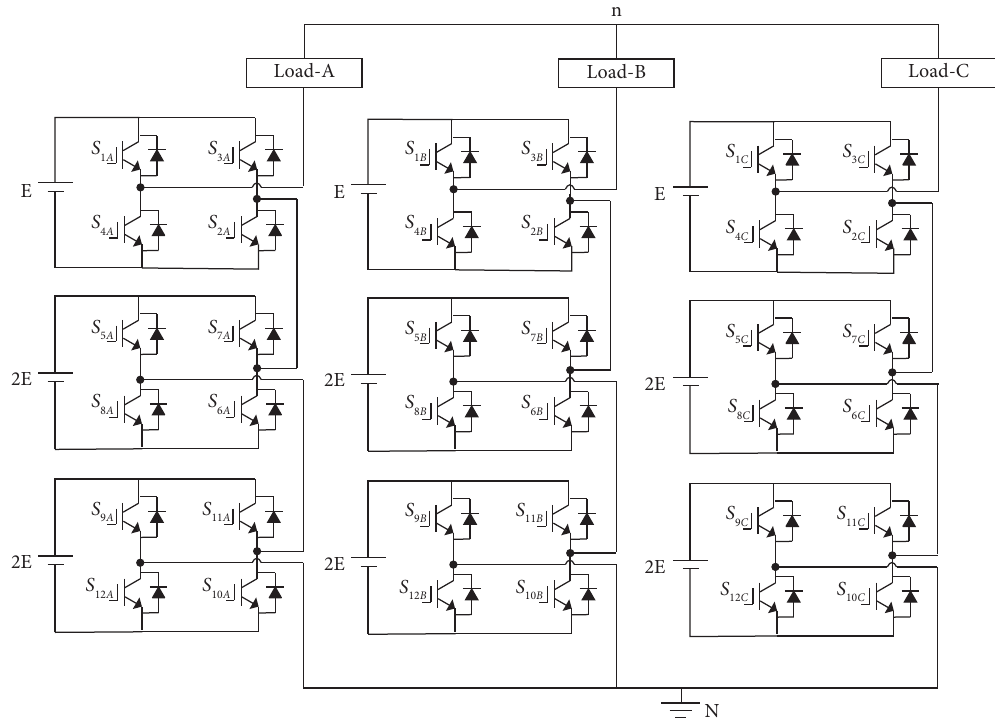
Figure 1: Tree phase asymmetric 11L CHB inverter confguration. Table 1: Switching states of eleven-level CHB inverter. Voltage level